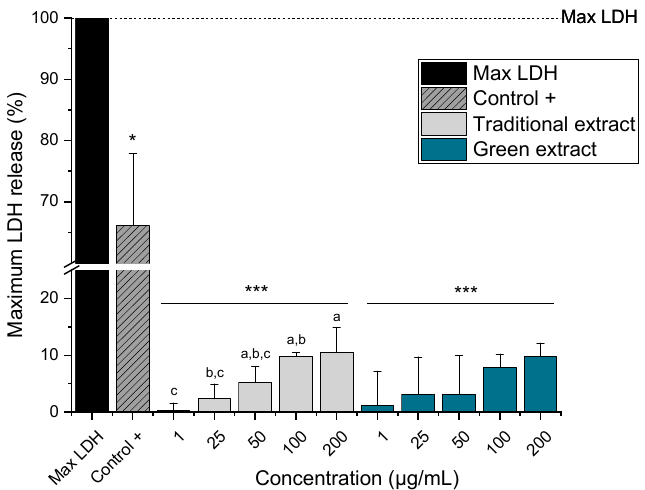
Figure 5. Release of lactate dehydrogenase (LDH) from HCT-116 cells after 24 h incubation with different concentrations of the omega-3 lipid extracts produced by the traditional method (traditional extract) and the green method by using Saczyme (green extract). LDH positive control (control +) used was provided by the kit. Maximum LDH release was determined by lysing the cells by using Triton-X100 for 45 min. Results are presented as mean + SD normalized to the maximum LDH (n = 3). Statistical differences compared to the maximum LDH were calculated with a one-sample Student’s t-test (* p , *** p < 0.05, 0.01, 0.001). Significant differences among the test concentrations were calculated with one-way ANOVA ( p < 0.05, a–c).